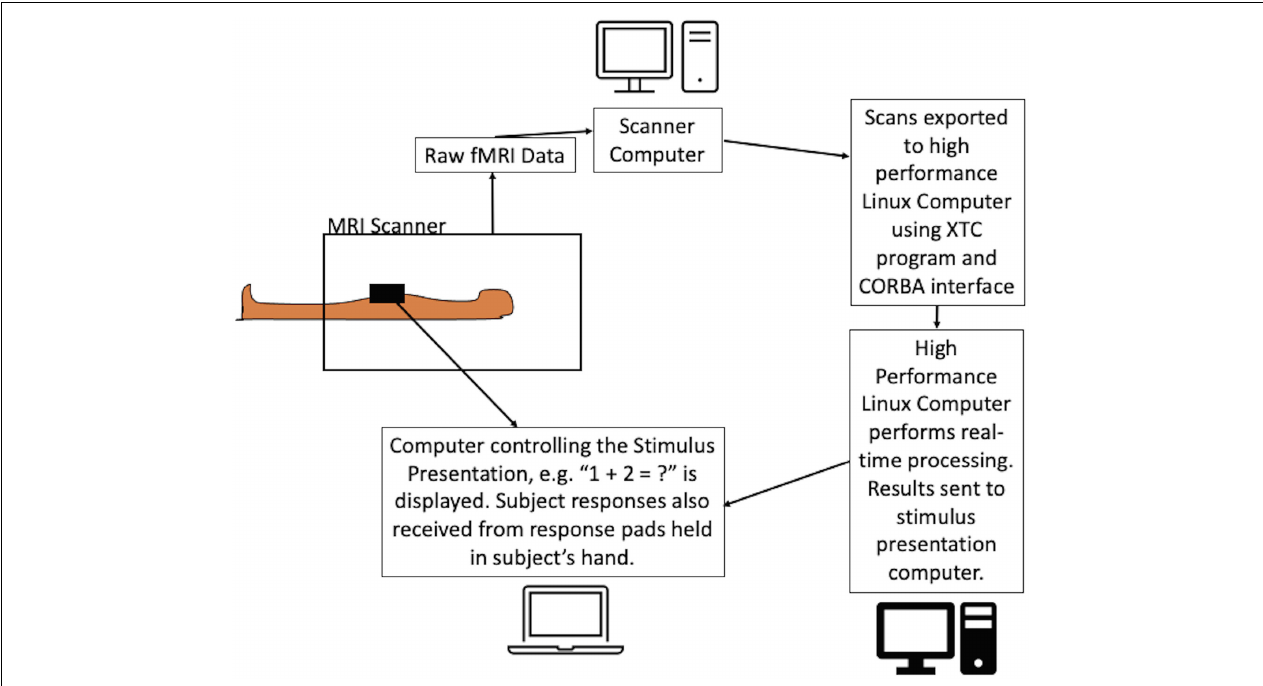
FIGURE 2 | Schematic of the experimental setup of the dynamic real-time fMRI process. The equations were presented to the subject while the scans were acquired using a dedicated computer. FMRI scans were exported in real-time from the scanner computer to the Linux workstation using the Philips XTC program and CORBA interface. Scans were preprocessed on the Linux workstation and SPRT statistics were calculated. The results were relayed back to the stimulus presentation program with an instruction to either continue or terminate the stimulus. The program allowed the flexibility to automatically terminate the presentation of the difficulty level or it could be overridden by the experimenter to continue presenting the stimulus. Note: where hospital firewalls are not an issue, the setup can be